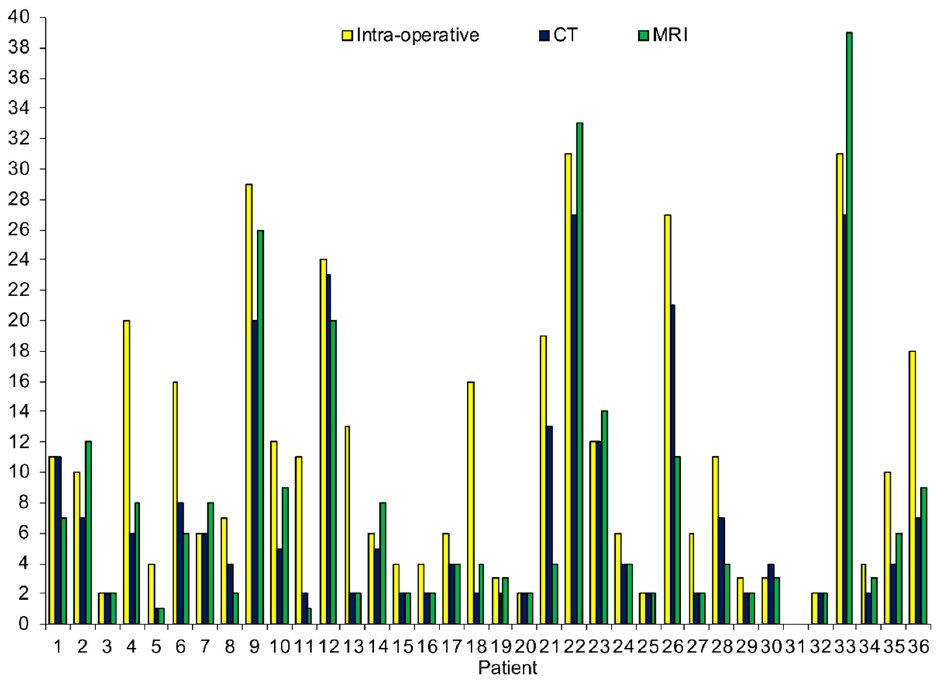
Figure 1. Total peritoneal cancer index score by individual patient.